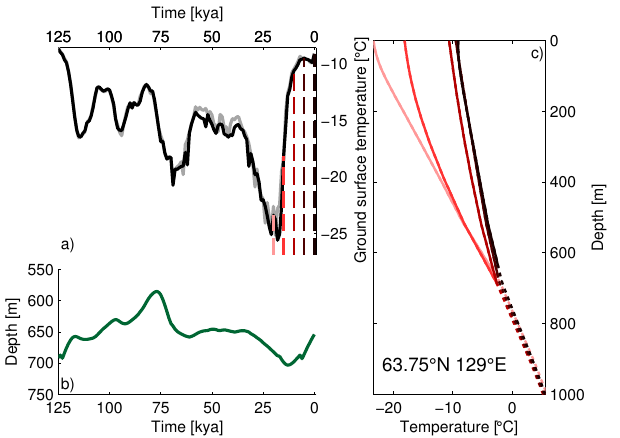
Figure 14. Same as Fig. 13 but for northern Canada. In (a) the ice thickness (dark blue) and the ground surface melting point tempera- ture T m (dotted black) evolution over the last glacial cycle are addi- tionally shown. Ice thickness for the simulations with zero porosity (light blue) is also shown.